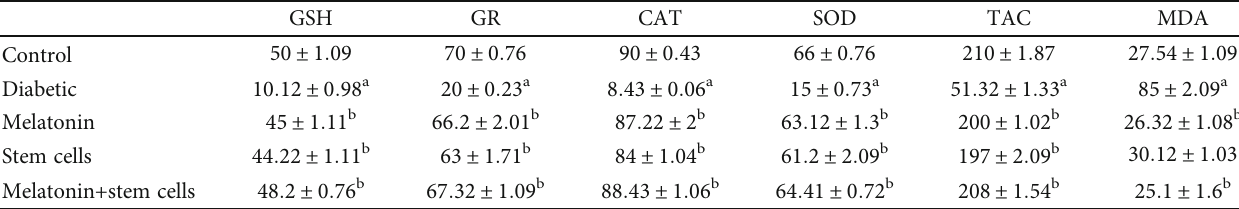
Table 2: Changes in retinal oxidative/antioxidant status.